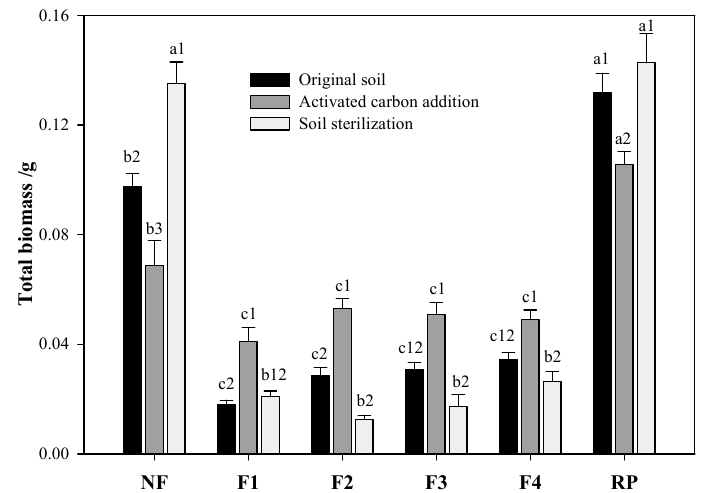
Figure 2. Effects of different forest soils on the growth of Phytolacca americana . Statistically significant differences ( p < 0.05) between the six soils or three soil treatments are denoted by different letters and by different numerals, respectively (NF: Nonforest, F1: Pinus densiflora forest, F2: Pinus densiflora+Quercus acutissima mixed forest, F3: Quercus acutissima forest, F4: Deciduous broadleaved mixed forest, and RP: Robinia pseudoacacia plantation).